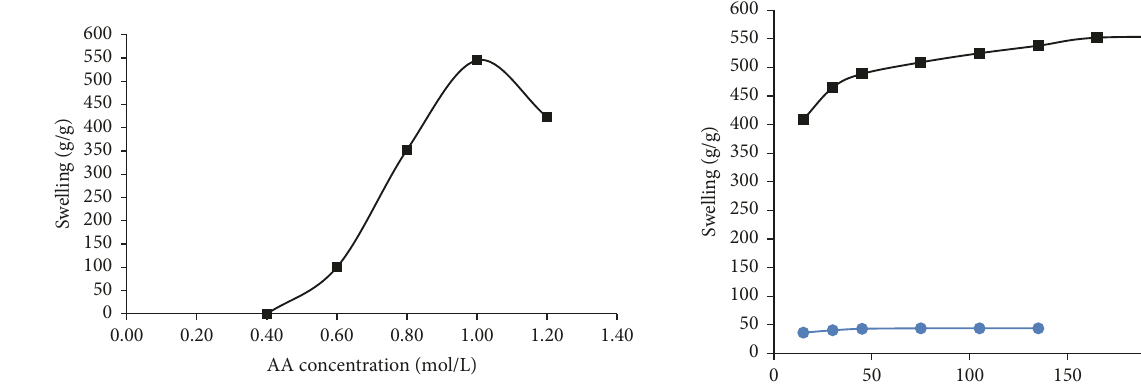
Figure 6: Effect of acrylic acid concentration on swelling capacity (reaction condition: 2.0 g/100 mL NaCMC, 0.01mol/L MBA, 70% neutralized AA, and 0.014 mol/L KPS at 70 ∘ C for 90 min).